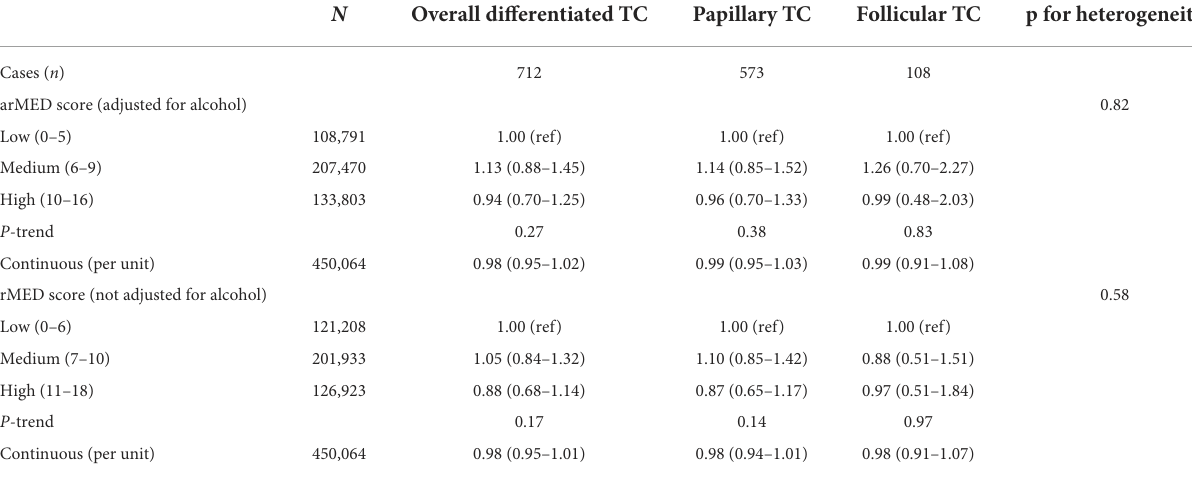
TABLE 3 Hazard ratios (95% Confidence Intervals) for the associations between relative Mediterranean diet score (rMED), adapted rMED (arMED) and differentiated thyroid cancer (TC) risk in the EPIC